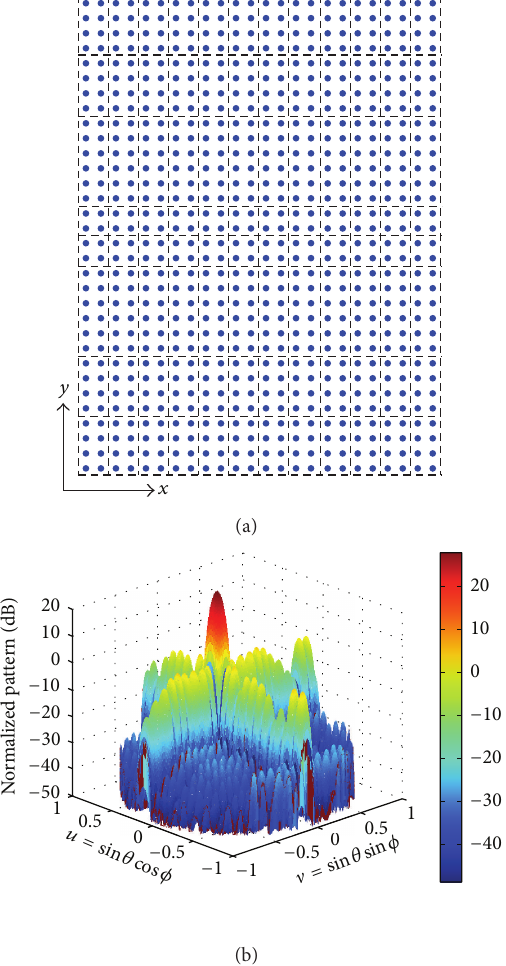
Figure 5: The optimization results of the planar array: (a) the optimized configuration and (b) the optimized 3D array pattern steered to ( − 45 ∘ , 10 ∘